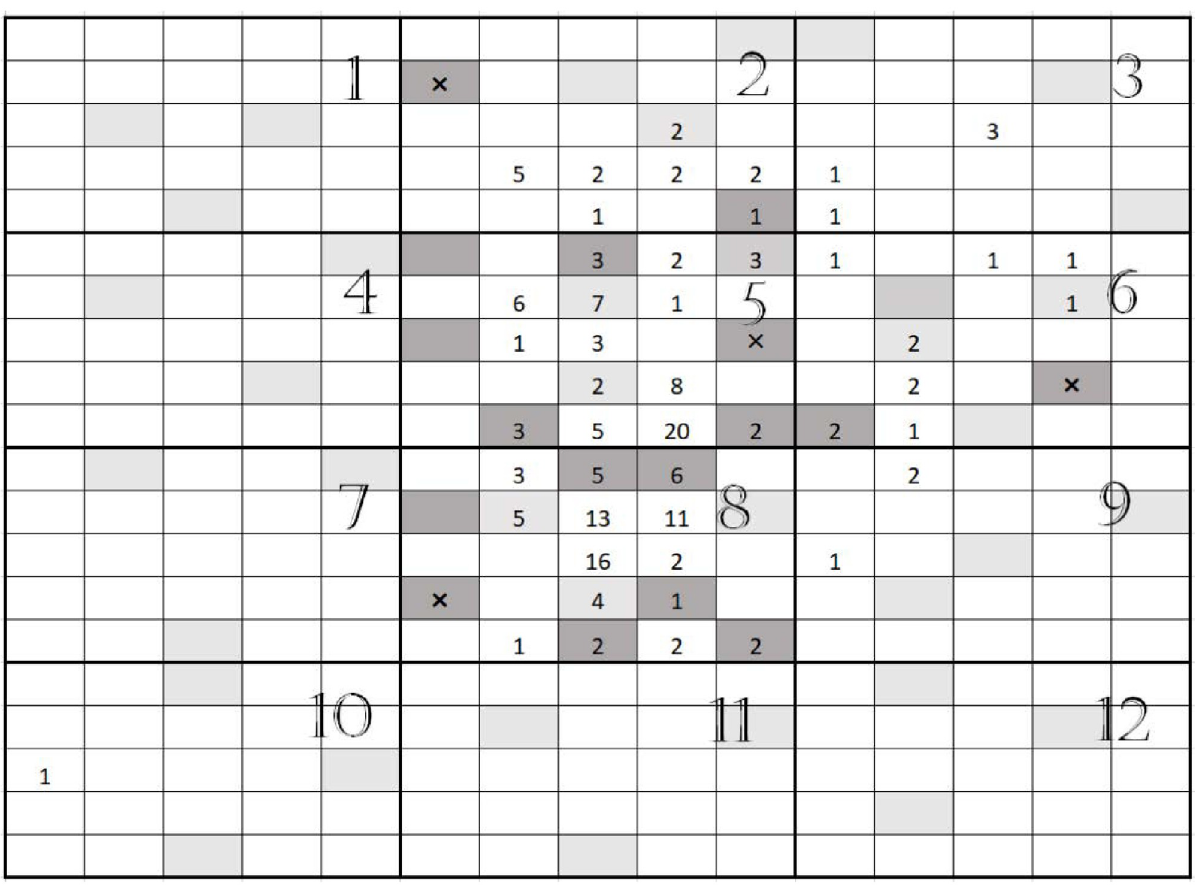
Fig 1. Castle Hill buttercups population. There are 300 quadrats of size 100 m 2 . The counts of buttercups are shown. The population site is partitioned into 12 primary units. All 12 primary units are selected. Three quadrats are selected from each PSU, in light gray. If all three selected quadrates are not empty, the sampling has been continued one at a time, sequentially, until three empty quadrats are selected. The sequentially selected quadrates are in dark gray and the last selected quadrats have × which are non-rare